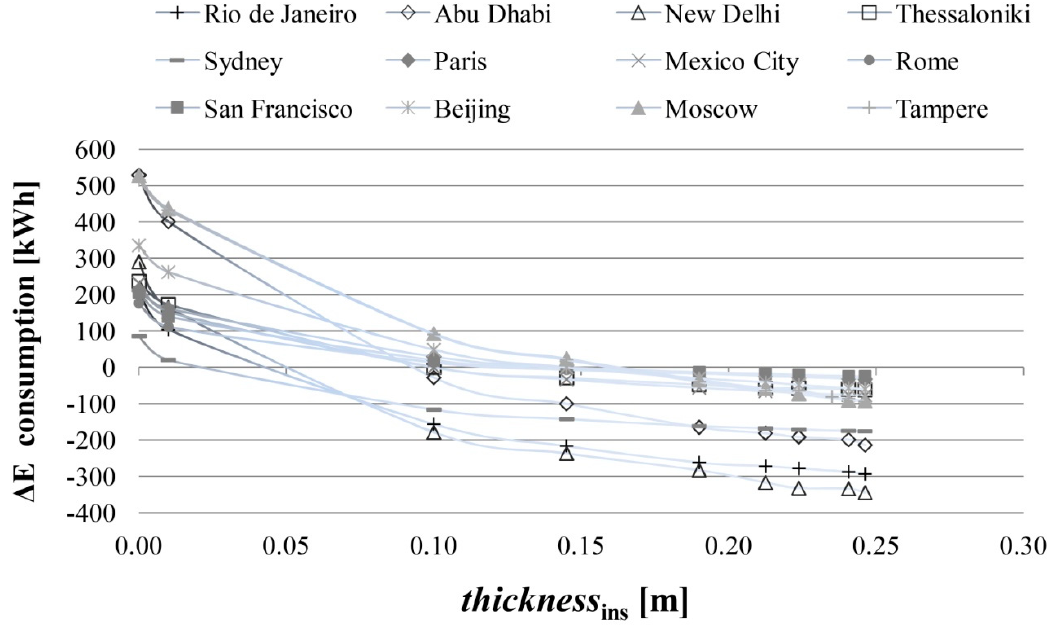
Figure 5. Variation of the annual building HVAC energy consumption di ff erence compared to the standard scenario varying only roof thermal insulation thickness in each climate zone with “standard